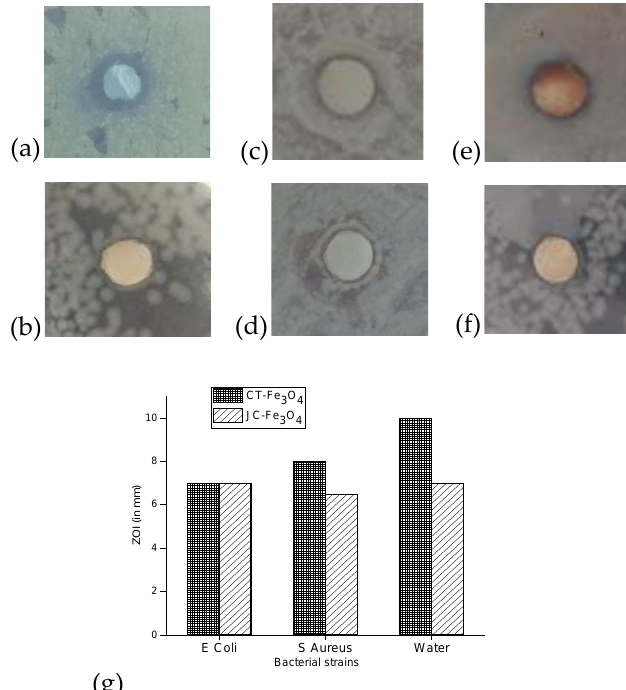
Figure 10. ZOI against water-born Gram-positive bacteria using ( a ) CT-Fe 3 O 4 NPs (10 mm diameter) and ( b ) JC-Fe 3 O 4 NPs (7 mm diameter); ZOI against E. coli (Gram-negative bacteria) ( c ) CT-Fe 3 O 4 NPs (7 mm diameter)and ( d ) JC-Fe 3 O 4 NPs (7 mm diameter); ZOI against S.aureus (Gram-positive bacteria) ( e ) CT-Fe 3 O 4 NPs (8 mm diameter) and ( f ) JC-Fe 3 O 4 NPs (6.5 mm diameter). ( g ) Relative zone of inhibition of CT-Fe 3 O 4 and JC-Fe 3 O 4 NPs against different bacteria.